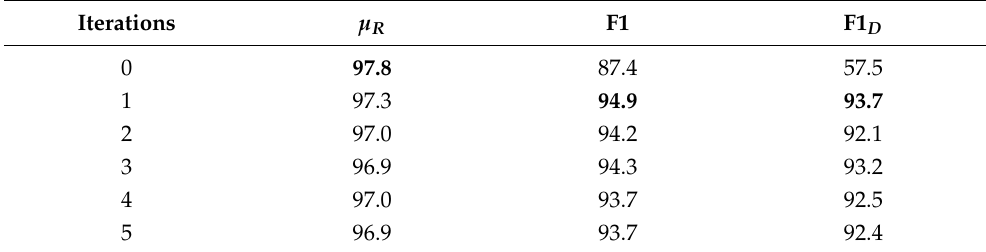
Table 6. MODS detection (F1/F1 D ) and water–edge estimation robustness ( µ R ) with respect to the number of SLR pseudo-label estimation and fine-tuning iterations. Best results for each metric are denoted in